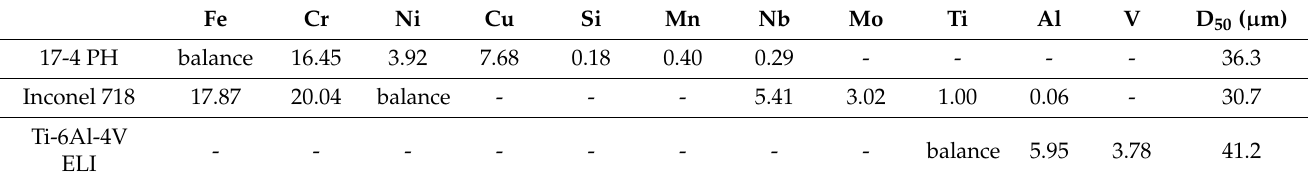
Table 1. Compositions (in wt.%) and size of 17-4 PH, Inconel 718, and Ti-6Al-4V